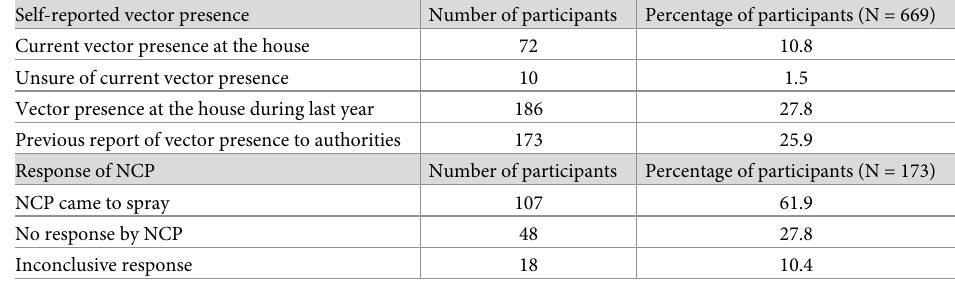
Table 2. Self-reported vector presence and responses of the National Chagas